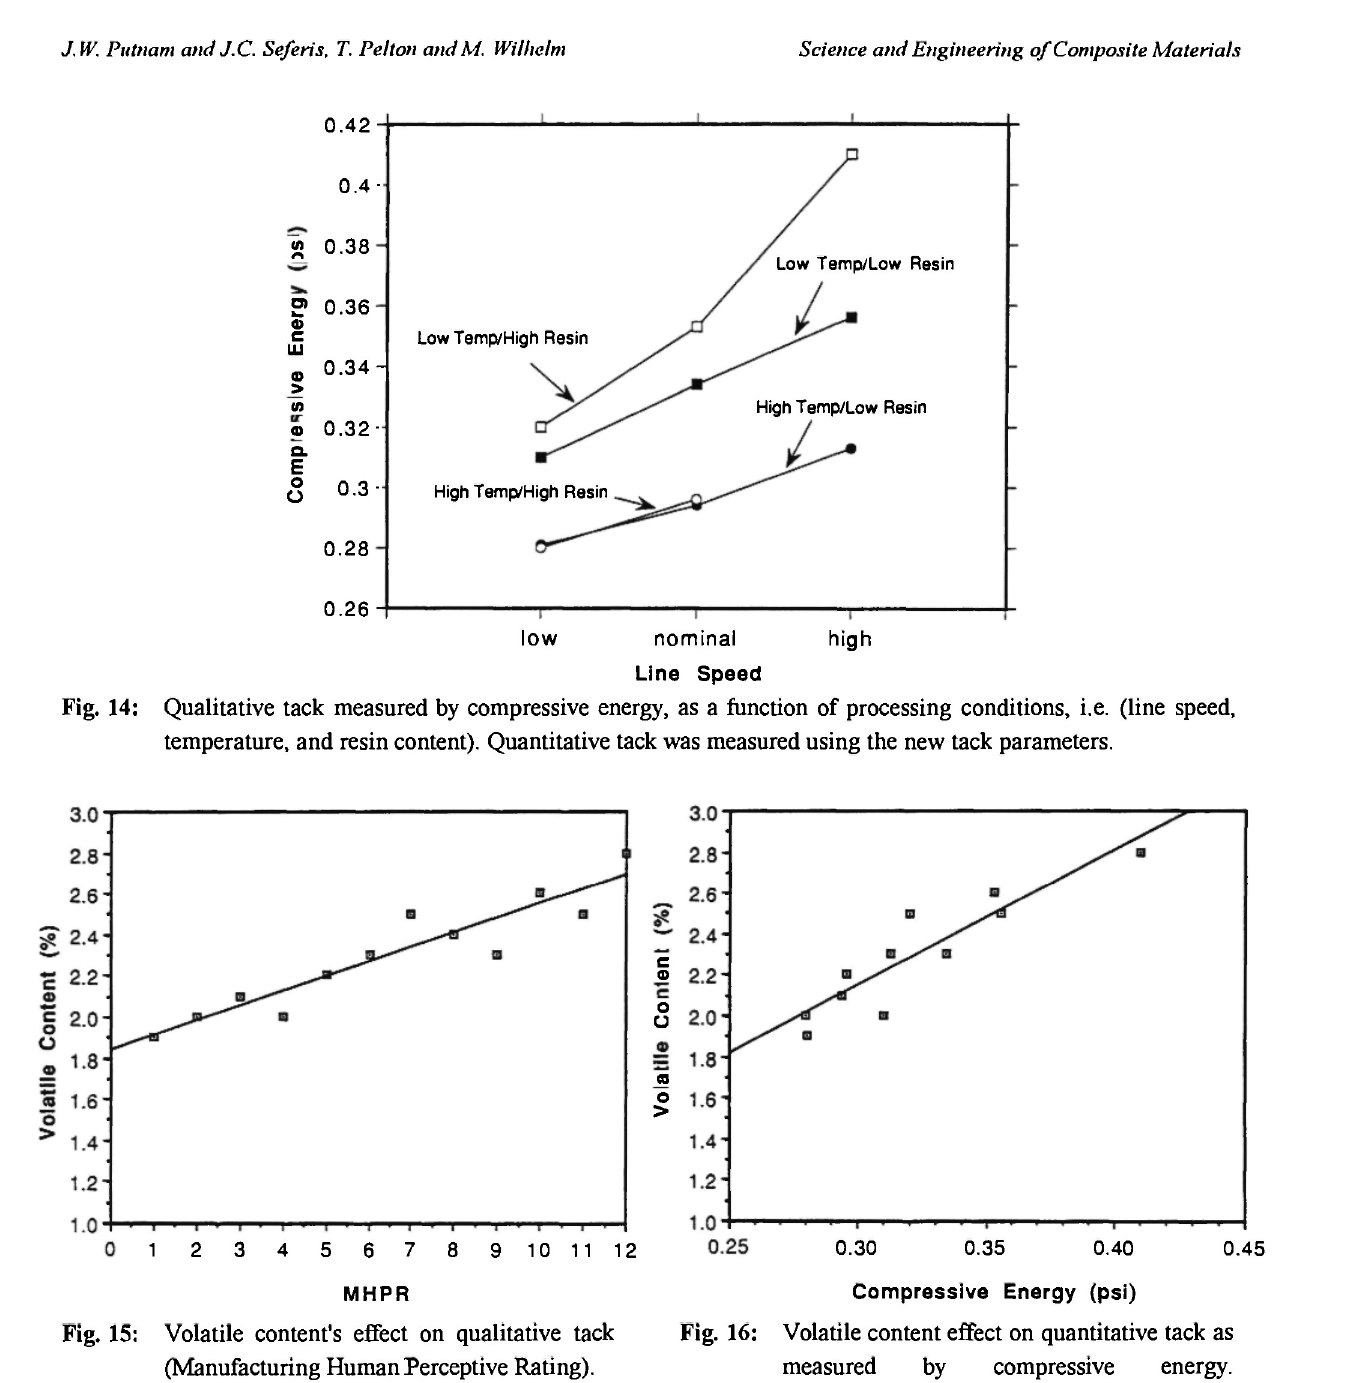
Volatile content's effect on qualitative tack (Manufacturing Human Perceptive Rating). increases, so does the MHPR. Quantitative tack, measured by compressive energy using the new tack parameters, also generally increases with volatile content as shown in Figure 16. The increased mobility of the resin again causes the prepreg to deform more during compression, which takes more strain energy.